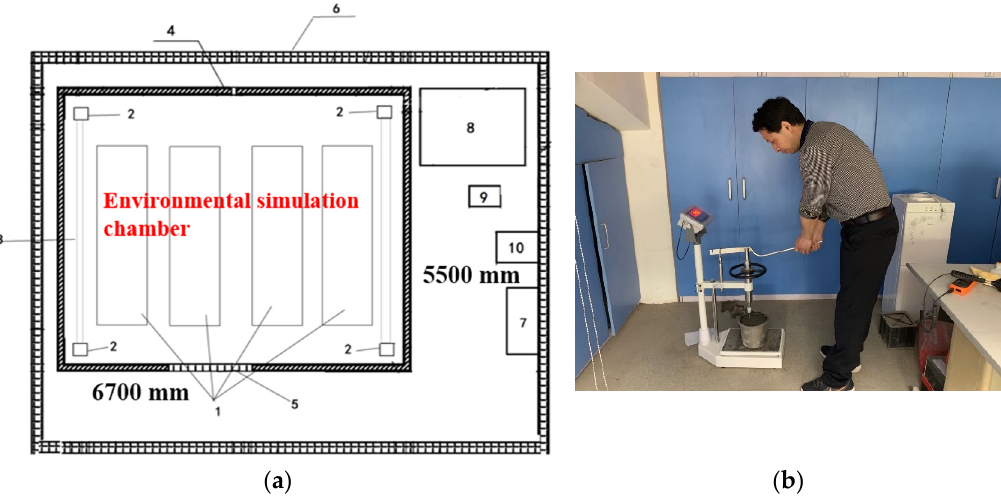
Figure 1. ( a ) Environmental simulation chamber. ( b ) Penetration resistance test. Note: 1—Test area, 2—embedded steel block, 3—hoisting system track, 4—polyurethane library board, 5—environmental simulation chamber entrance, 6—laboratory exterior wall, 7—computer, 8—compressor, 9—environmental simulation chamber control cabinet, 10—host control cabinet.